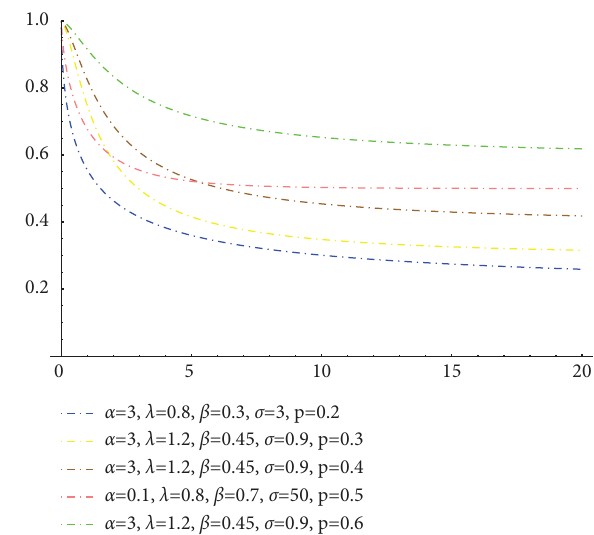
Figure 2: Te survival function of the PGcr/GeTNH model for diferent parameters